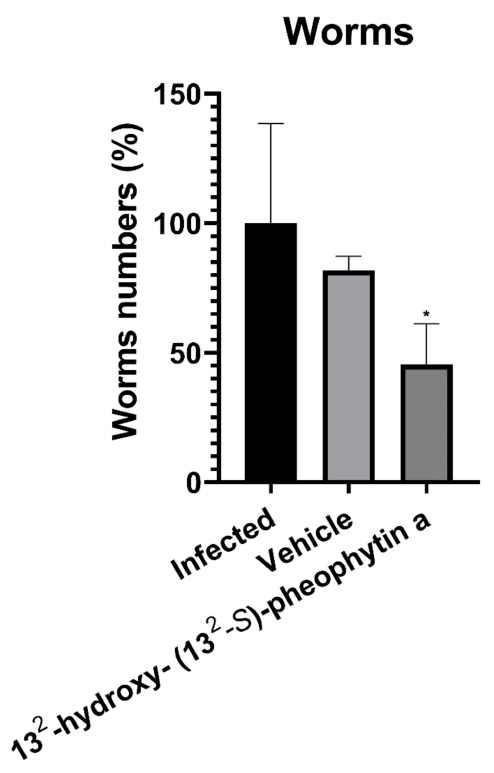
Figure 7. Number of Hymenolepis nana worms after 10 days of treatment. Male BALB/c mice were fed with 500 eggs, and we observed the feces after 10 days of infection. After the eggs appeared in the feces, 13 2 -hydroxy-(13 2 -S)-pheophytin a was administered orally at 0.025 g/kg/day for 10 days, and a comparison was made with the infected group. * p < 0.05 indicates a significant difference versus the infected